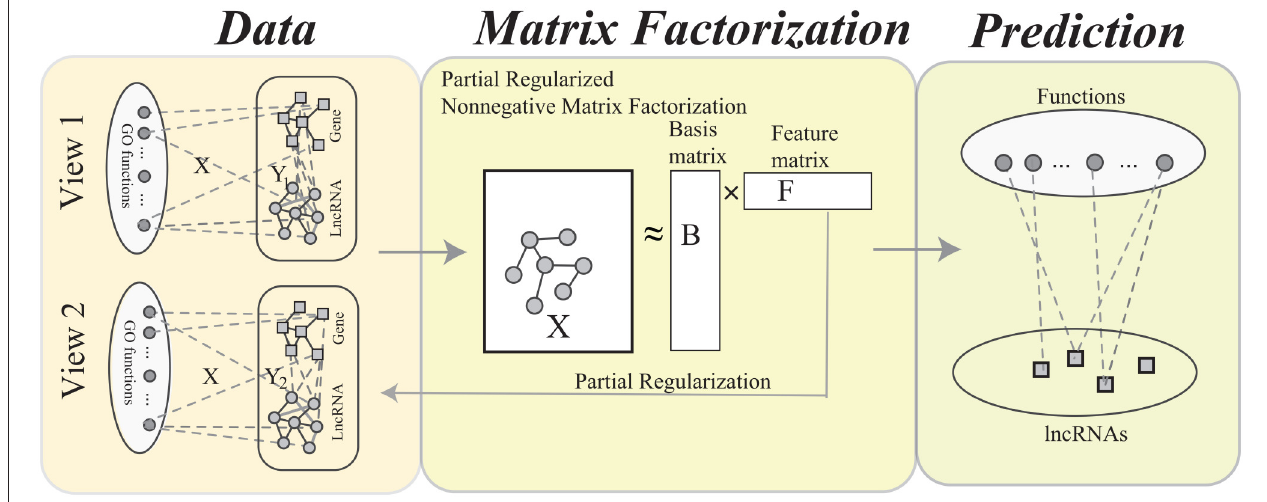
FIGURE 2 | The flowchart of the MPrNMF algorithm, which consists of three components: network construction, matrix factorization and function prediction. In the network construction, each type of heterogenous lncRNA-gene associations is used to construct a bi-colored network. The matrix factorization procedure obtains approximation of lncRNA(gene)-ontology associations X , where the feature matrix F reflects multiple lncRNA-gene associations. The function prediction procedure is based on the decomposed matrices.